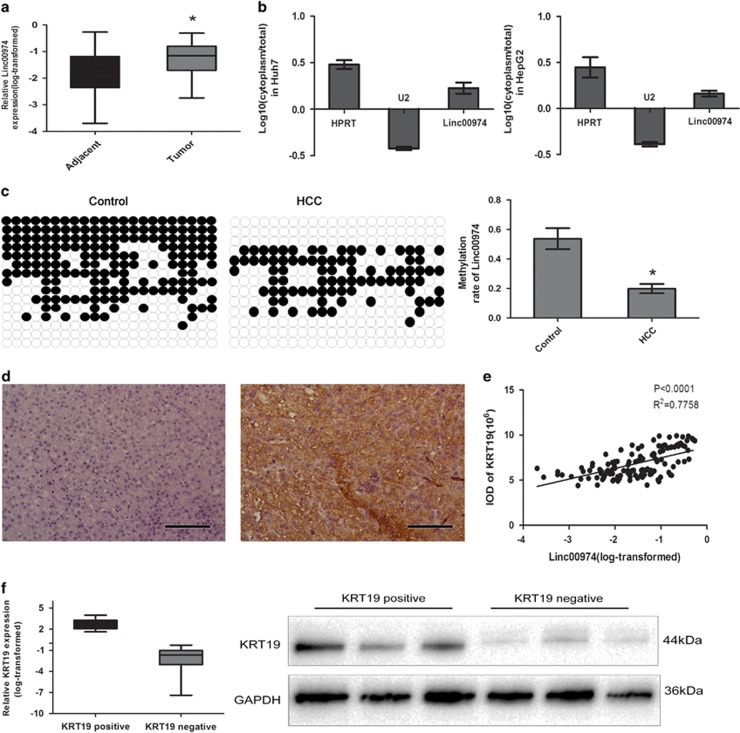
Linc00974 was upregulated with a high correlation with KRT19 in HCC. (a) A relatively increased level of Linc00974 was detected in HCC tissues compared with the corresponding adjacent tissues (n=150). Data was log-transformed as presented with mean±S.D. (b) Subcellular localization investigation indicated that the transcript for Linc00974 was located mainly in the cytoplasm of Huh7 and HepG2 cell lines, according to the results of RT-PCR amplified with separated cytoplasm RNA and nucleus RNA. HPRT was used as the control for cytoplasmic expression and U2 for cytonuclear expression. (c) The bisulfite sequencing method was used to detect methylation of CpG island predicted in Linc00974. The methylation level of the Linc00974 promoter was downregulated in tumor tissues compared with the corresponding adjacent tissues. (d) Paraffin sections from the above 150 patients were used to examine KRT19 expression; the left indicated a negative stain of KRT19 while the right presented the positive stain. (e) Pearson correlation showed a positive correlation between expression levels of KRT19 and Linc00974 with a P<0.0001, R2=0.7753. (f) Relative expression level of KRT19 mRNA and protein in HCC samples. Data was log-transformed as presented with mean±S.D. (*P<0.01)